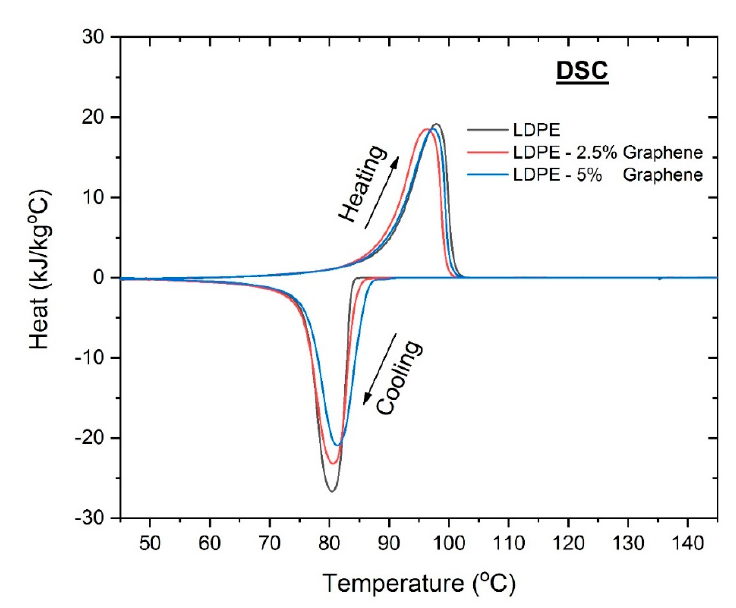
Figure 7. Typical DSC analyses of the 2.5% and 5% graphene containing samples compared with pure LDPE.